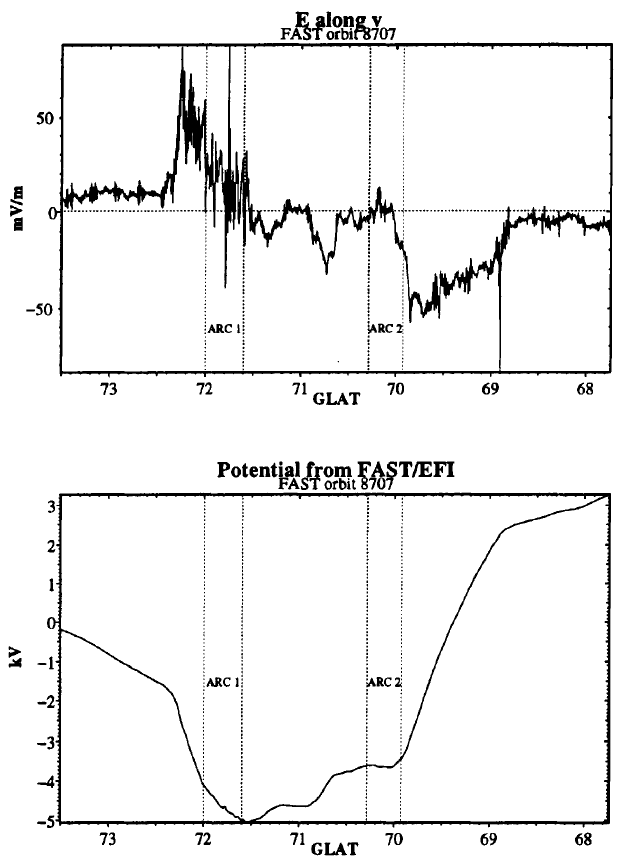
Fig. 7. FAST electric field along spacecraft orbit ( upper panel ) and integrated potential along the orbit ( lower panel )